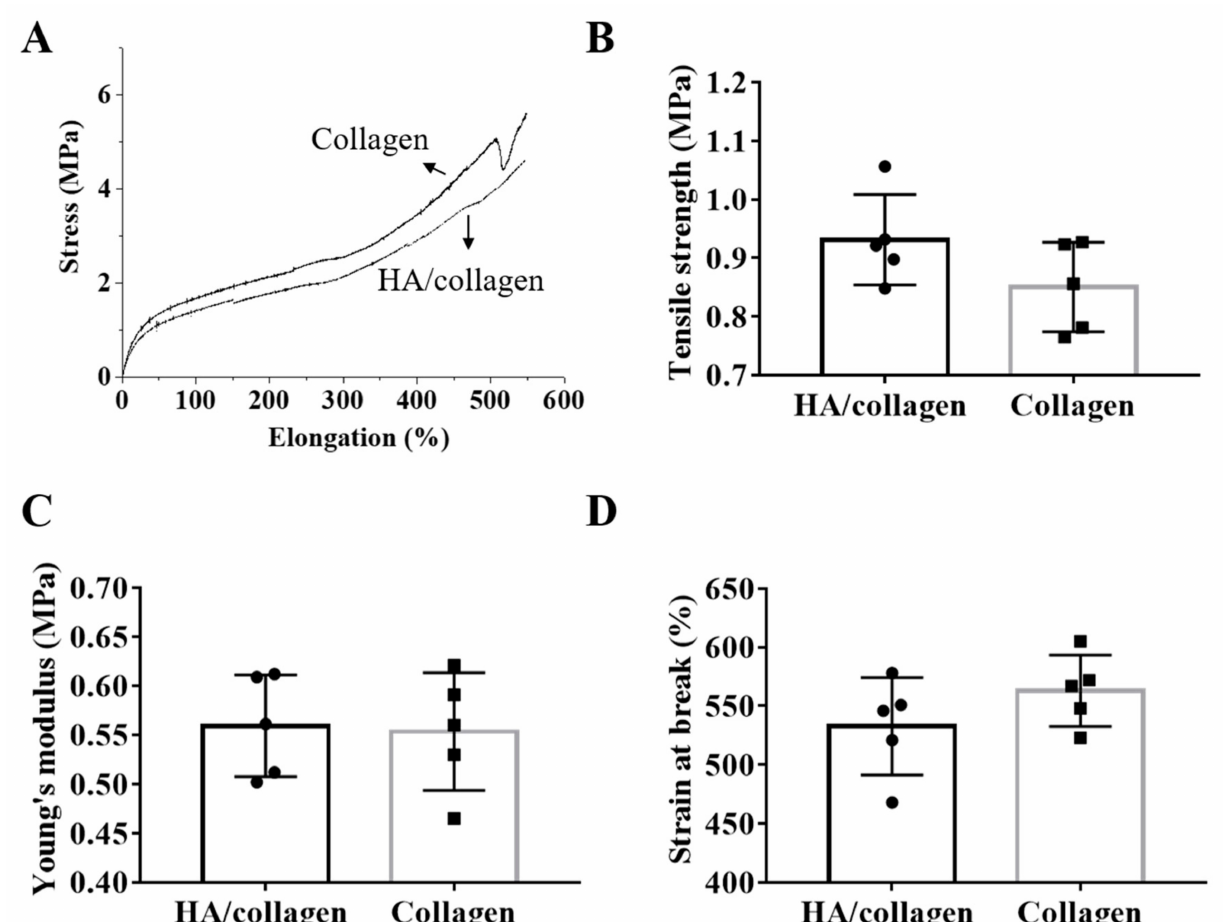
Figure 3. Mechanical properties. Relative to cross-linked electrospun HA/collagen and collagen nanofibers: ( A ) typical stress–strain curves, ( B ) ultimate tensile strength, ( C ) Young’s modulus and ( D ) strain at